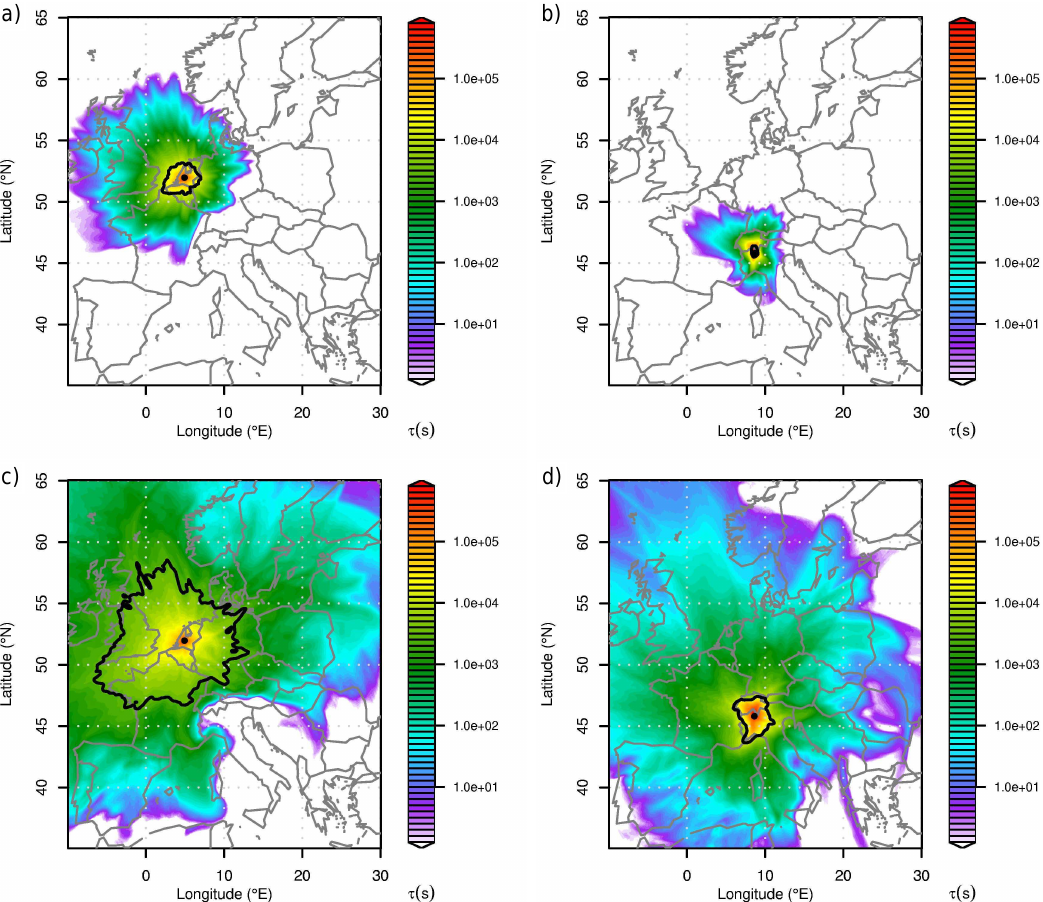
Fig. 1. Total annual surface residence times (footprints) given in units seconds (colour scale) and boundary of catchment area (thick black line) for the sites Cabauw (NL11, a , c ) and Ispra (IT04, b , d ) and two integration intervals, 12h (a, b) and 48h (c,